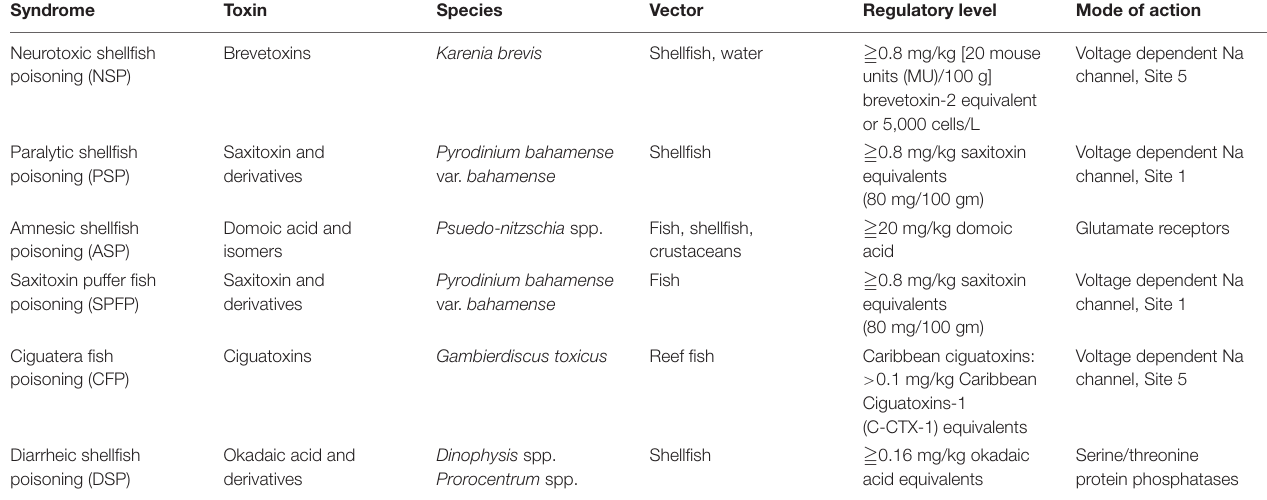
TABLE 1 | HAB Syndromes and associated marine HAB species and toxins reported from Florida.